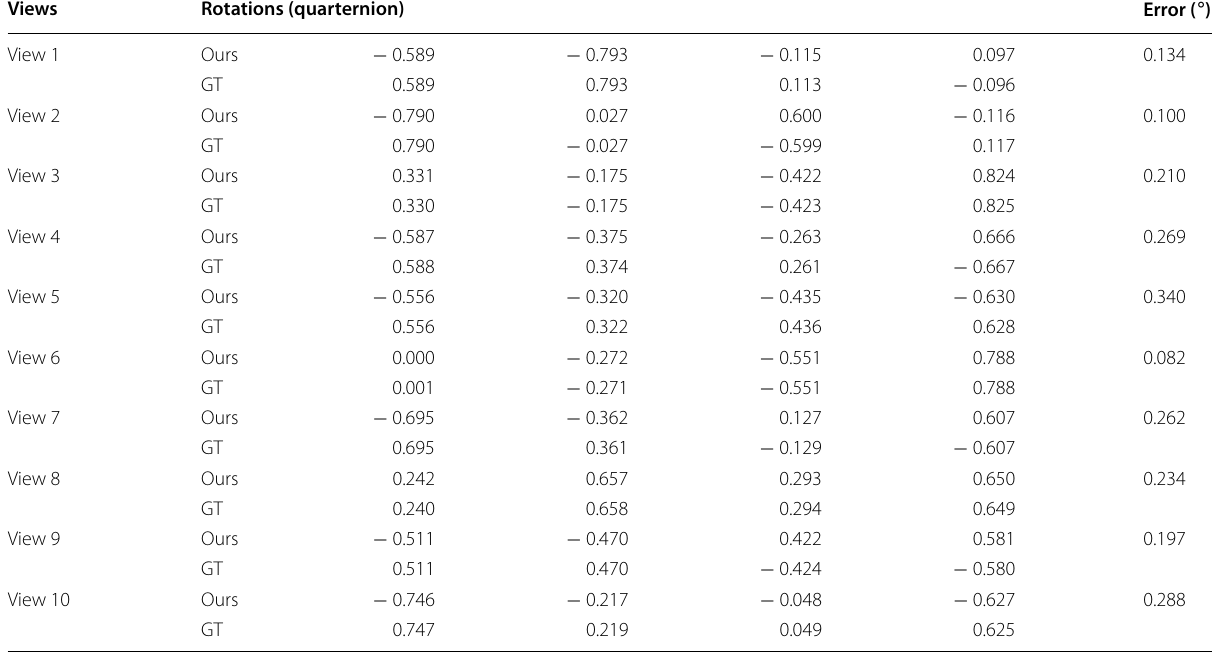
Figure 9 shows the 3D point clouds generated for the chair test split. The reconstruction errors are defined by the point-wise 3D Euclidean distance using Eq. (5), which represents the 3D shape similarity [50]; generated and ground truth point clouds, respectively. According to Table 3, E is scaled by a factor of 100; our results are more accurate.